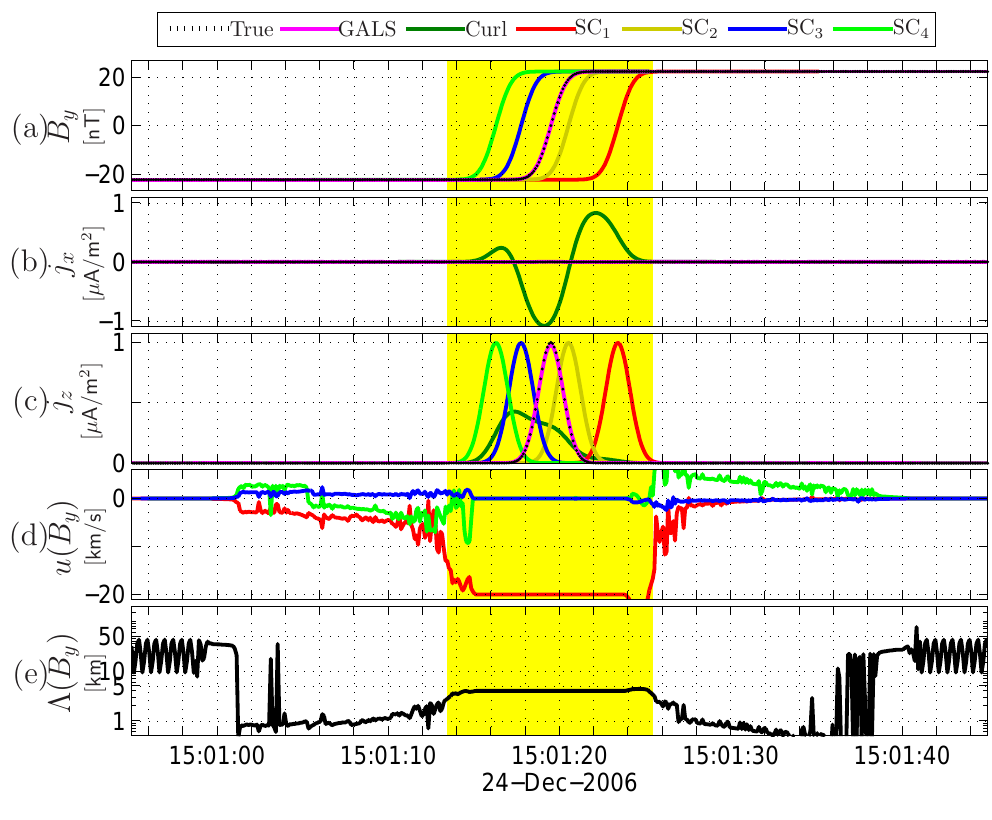
Fig. 1. (a) A current sheet passing four satellites, s 1 – s 4 , in the frame of reference moving with the satellites. (b) The current sheet and the spacecraft in the reference frame moving with the sheet. Fig. 3. (a) Magnetic field y component for the narrow current sheet Fig. 3. (a) Magnetic field y-component for the narrow current sheet in Fig. 2 as observed by the four satellites. The reconstructed field from GALS (magenta) and the true field (black, dotted) are also shown. (b–c) Current density J x and J z from GALS (magenta), the curlometer in Figure 2 as observed by the four satellites. The reconstructed field (dark green), and the single-spacecraft method (red, yellow, blue, and green). The true current is shown with the black dotted line. (d) GALS from GALS (magenta) and the true field (black, dotted) are also estimated structure velocity u x , u y and u z (red, green and blue) for the B z component. (e) Resolution parameter 3(B y ) obtained by GALS in the reconstruction of B y . The highlighted time window indicates the used coherence time T c = 12s. shown. (b)–(c) Current density J and J from GALS (magenta), x z the curlometer (dark green), and the single-spacecraft method (red, value of T c , more space-time observation points are included coherence time, T c = 6 s as in Fig. 5, we see in panel (i) that yellow, blue, and green). The true current is shown with the black in the GALS least squares problem. The extra information the velocity around the time of the current sheet crossing from the included time domain is used to improve the spa- (about 13:11:46.50) is approximately consistent with the dotted line. (d) GALS estimated structure velocity u , u and u x y z tial resolution. Of course, this requires that the shape of the (red, green and blue) for the B component. (e) Resolution parame- investigated convective structure is approximately stable on z these time scales. In this case, the GALS current will there- ter Λ( B . The high- ) obtained by GALS in the reconstruction of B y y fore be more similar to the result from the single-spacecraft lighted time window indicates the used coherence time T = 12 s. method, which is highly capable to resolve small scale struc- c tures. In panels (d–f) of Fig. 5 we clearly see that the GALS result rather closely follows the single-spacecraft currents.